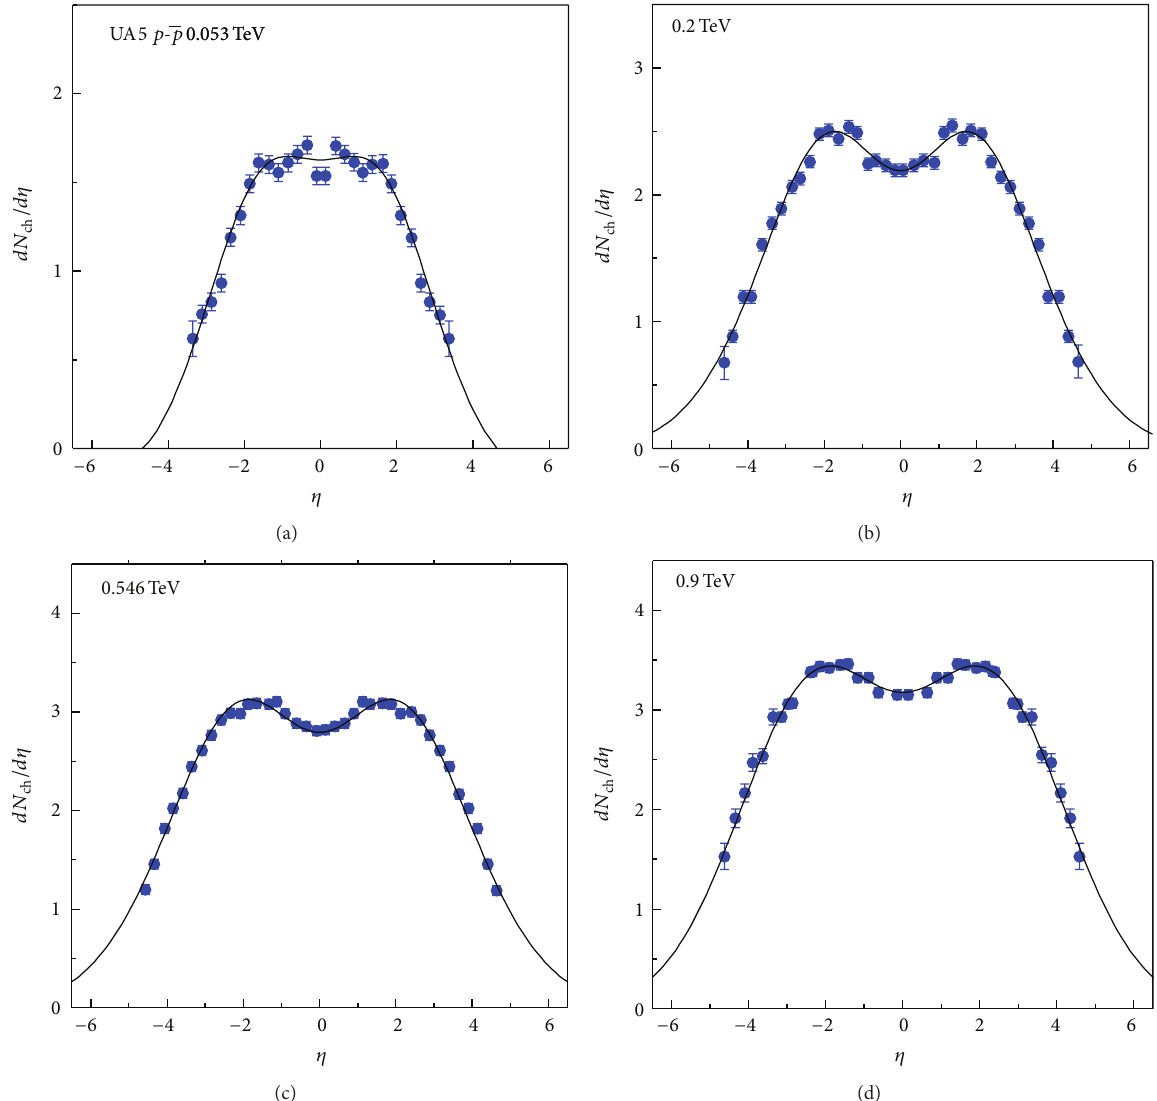
Figure 1: The pseudorapidity distributions, 𝑑𝑁 ch /𝑑𝜂 , of charged particles produced in inelastic 𝑝 - 𝑝 collisions at √𝑠 𝑁𝑁 = 0.053 (a), 0.2 (b), 0.546 (c), and 0.9 TeV (d). The symbols represent the experimental data of the UA5 Collaboration [18], and the curves are our calculated